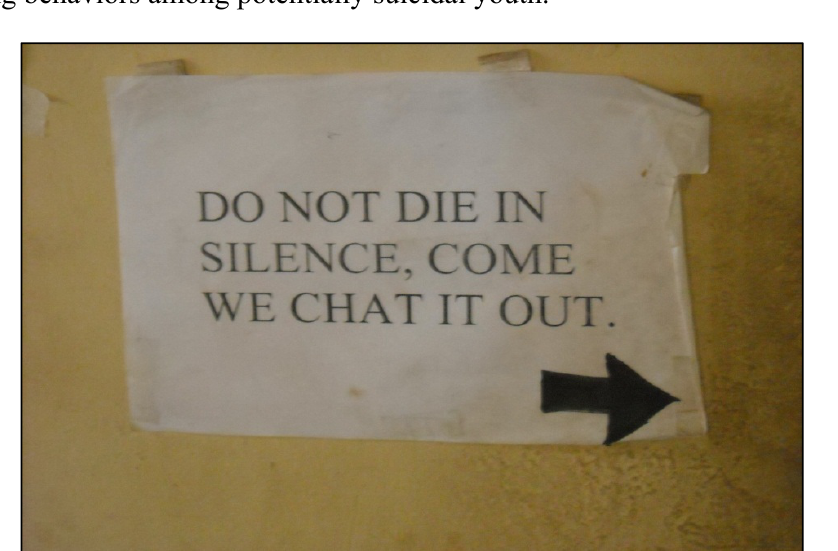
Figure 2. Note posted on wall in Drop-in Center, by UYDEL staff, to encourage help-seeking behaviors among potentially suicidal